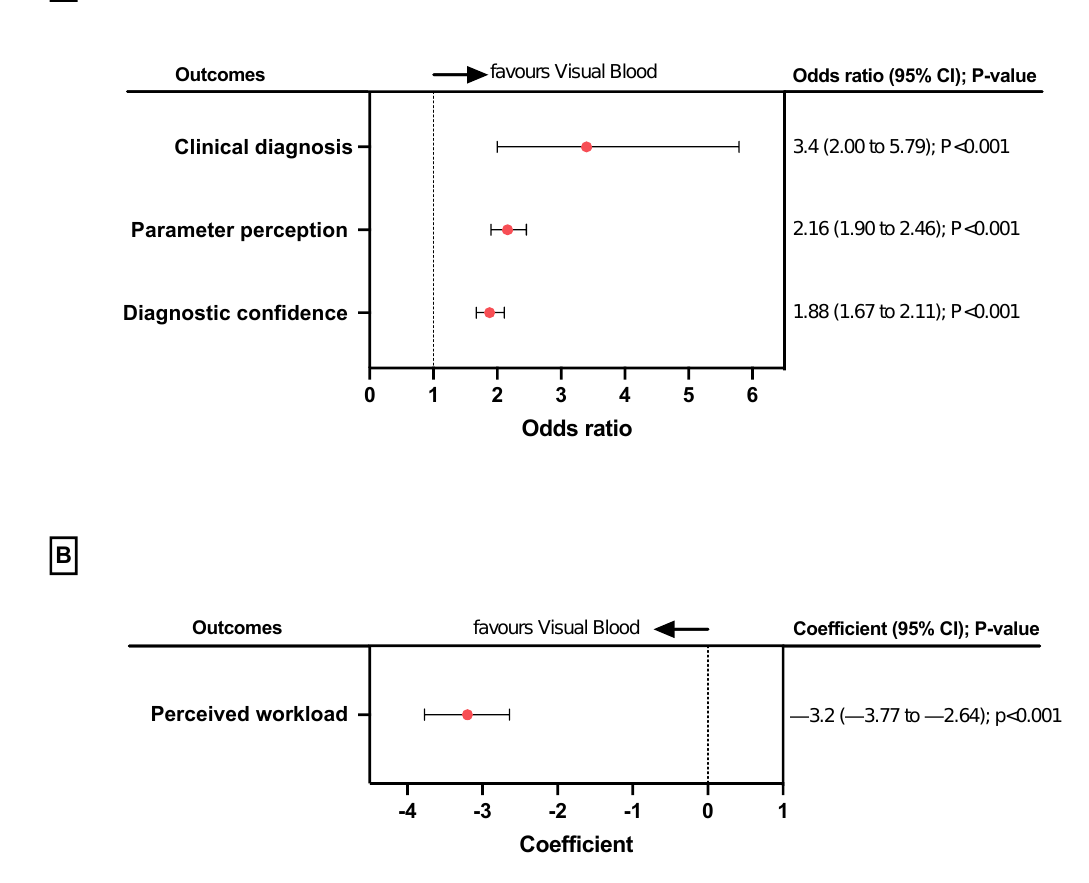
Figure 3. The results of the second part of the study. ( A ) The forest plots present the results of the mixed logistic regression models with a random intercept per participant for the outcomes of clinical diagnoses, parameter perception, and diagnostic confidence ( B ). The forest plot presents the linear mixed model results for the outcome of perceived workload. A negative coefficient means a lower workload using VB. CI, confidence interval.